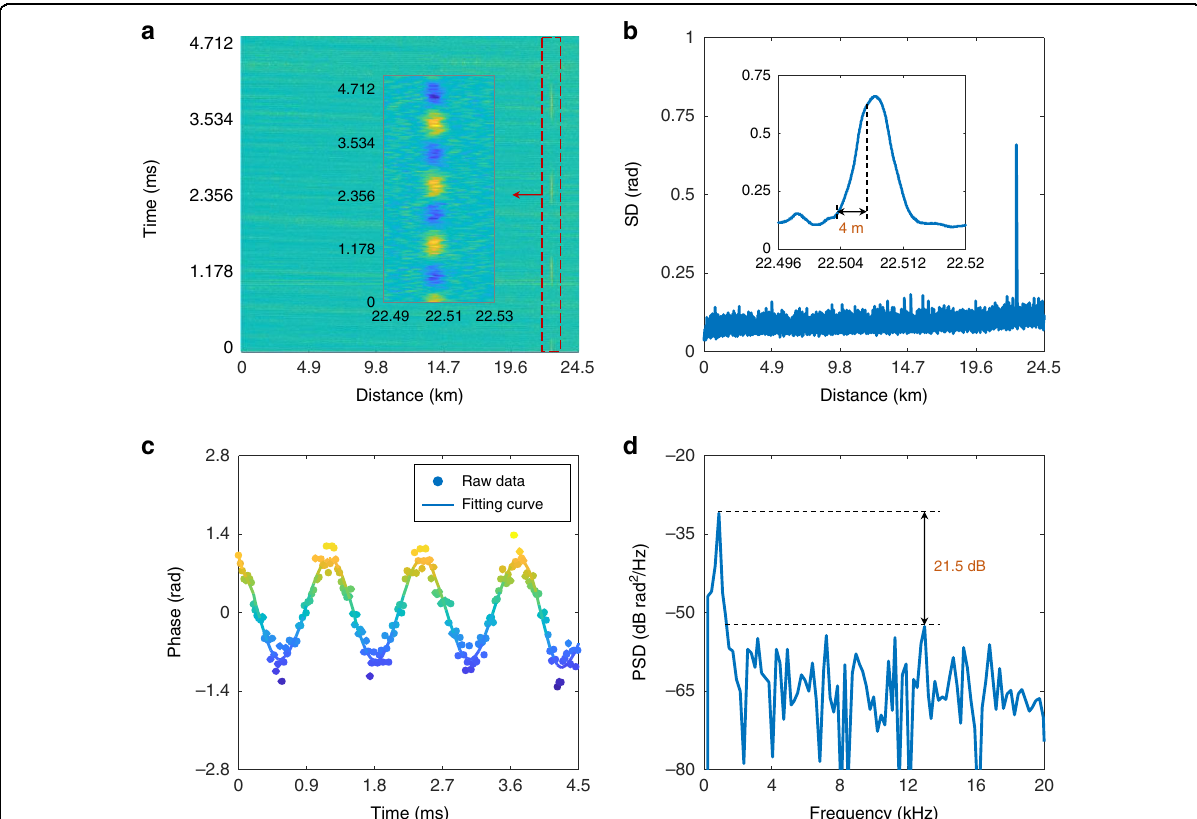
Fig. 5 Time and frequency characteristics of the measured vibration. a The distance – time distribution of the differential phases along the fi bre, with a vibration applied at around 22.5 km. b Phase SD along the fi bre with a spatial resolution of ~4 m. c Time-domain waveform and d corresponding PSD of the measured